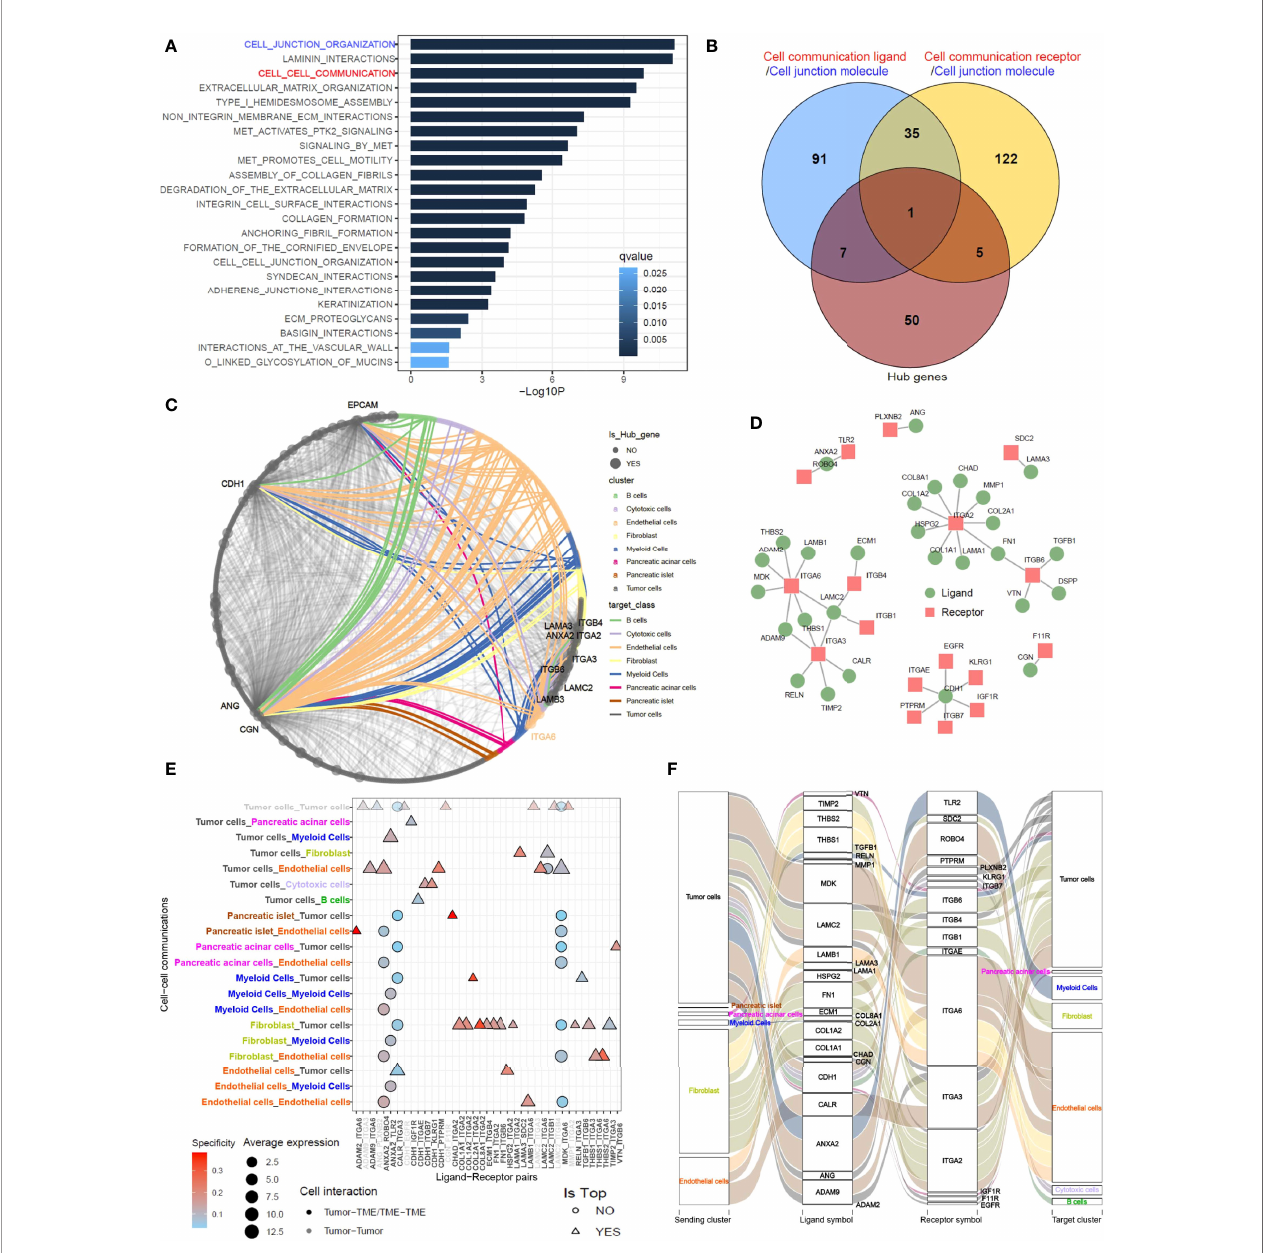
FIGURE 5 | Cell junction molecule – mediating tumor cell – TME communications dominate the prognosis-related gene network. (A) Functional enrichment analysis was performed using gene signatures from the Reactome database to unveil the dominant molecular function of hub genes constituting prognosis-related networks. (B) Hub genes functioning as cell junction molecules to modulate external cellular communication (ligands/receptors) were selected for the following study. (C) A gene correlation network shows the links between the gene pairs initiated from central cell – cell communication mediators (named in the graph) to their closely connected (R > 0.5) genes within modules. Colored edges represent the links involving MEMGs. (D) The hub gene – related ligand – receptor pairs were extracted from the connectomeDB2020 database for cell – cell communication prediction in a PDAC single-cell dataset. (E) The cell – cell communications mediated by each ligand – receptor pair were determined using Network Analysis Toolkit for the Multicellular Interactions (NATMI) software. The top cell – cell communication pattern bridged by each ligand – receptor pair was noted. (F) Alluvial diagram represents the hub gene – associated ligand-receptor pairs engaged in tumor cell – TME